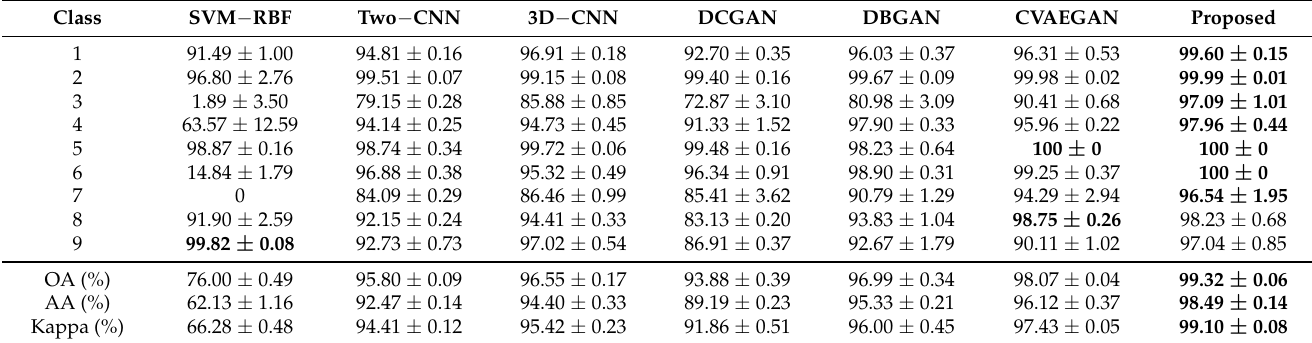
Table 10. Classification results on the PaviaU data set.